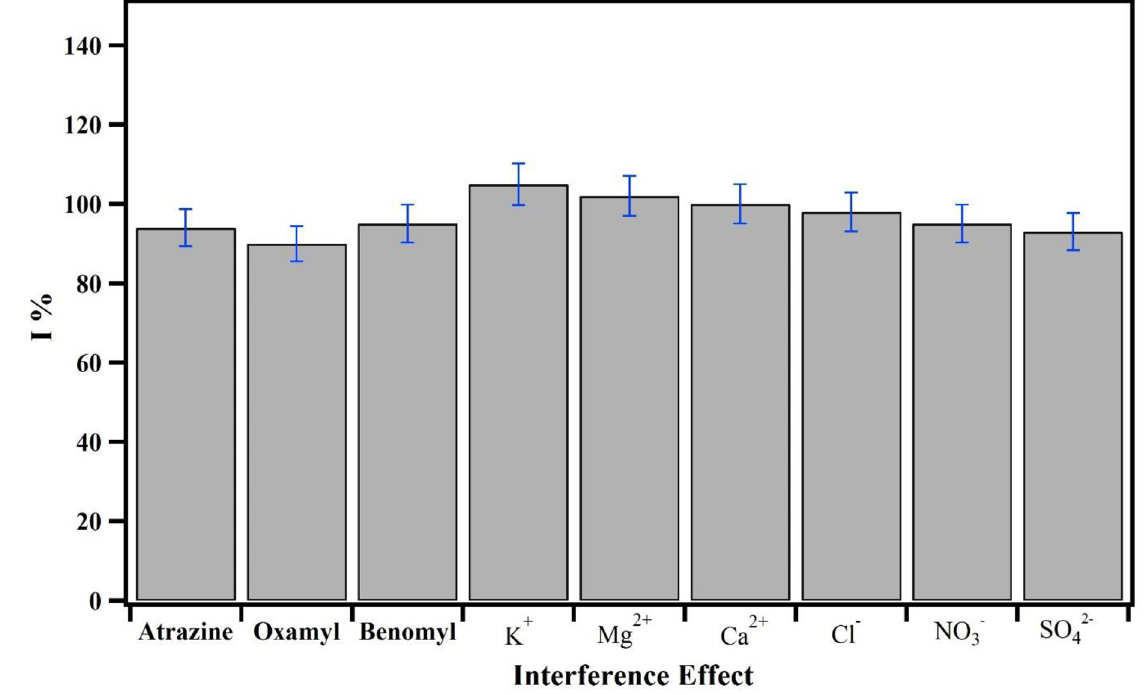
Fig 5. Effects of inorganic ions and several interfering pesticides on detection of CBZ ( Δ I %).